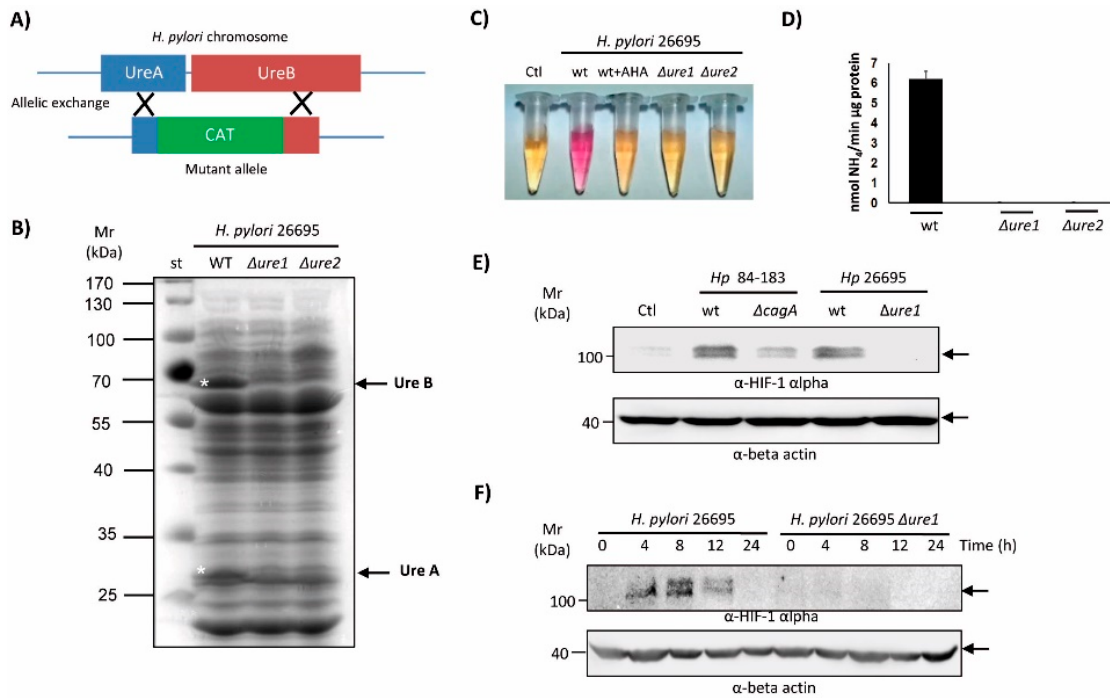
Figure 3. Characterization of the urease mutant in the H. pylori 26695 strain. ( A ) Schematic indicating how the urease mutant ( ∆ ureA / B ) in the H. pylori 26695 strain was obtained by allelic exchange. ( B ) Protein extracts (80 µ g) from H. pylori 26695 and resistant ∆ ureA / B clones 1 and 2 were separated by SDS-PAGE (10%) and then stained with Coomassie blue. Asterisks and arrows indicate the positions of UreA and UreB proteins, and the molecular weight markers (10–100 kDa) are shown to the left. A representative gel is shown. ( C ) A suspension of either parental bacteria or ∆ ureA / B clones 1 and 2 ( ∆ ure1 and ∆ ure2 ) were added to Brucella broth supplemented with urea 5 mM and the pH indicator red phenol. As a control of the reaction, the urease inhibitor acetohydroxamic acid (AHA, 20 mM) was included. A representative assay is shown. ( D ) Quantitative determination of urease activity in protein extracts from the H. pylori 26695 parental strain and its ∆ ureA / B mutants, clones 1 and 2 ( ∆ ure1, ∆ ure2 ). Values are expressed as moles of NH 4 / min / µ g protein (means ± SEM, n = 3, p ≤ 0.05). ( E ) AGS cells were infected with H. pylori parental 84-183 and 26695 strains, or their ∆ cagA and ∆ ureA / B clon 1 ( ∆ ure1 ) mutants, respectively, at MOI 100 for 8 h. Protein extracts were prepared and separated by SDS-PAGE on 10% gels. HIF-1 α and β -actin protein levels were detected by Western blotting. A representative blot is shown. ( F ) AGS cells were infected for 24 h with H. pylori 26695 or the ∆ ureA / B mutant clone 1 ( ∆ ure1 ) at MOI 100. Protein extracts were prepared and separated by SDS-PAGE. HIF-1 α and β -actin protein levels were detected by Western blotting. A representative blot is shown.